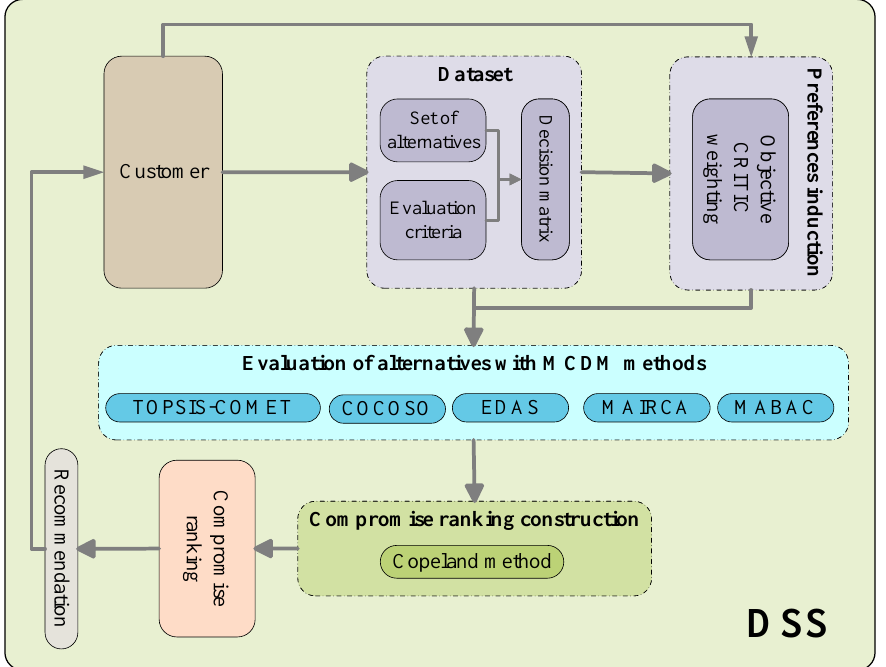
Figure 1. The flow chart of the DSS with component based on MCDM